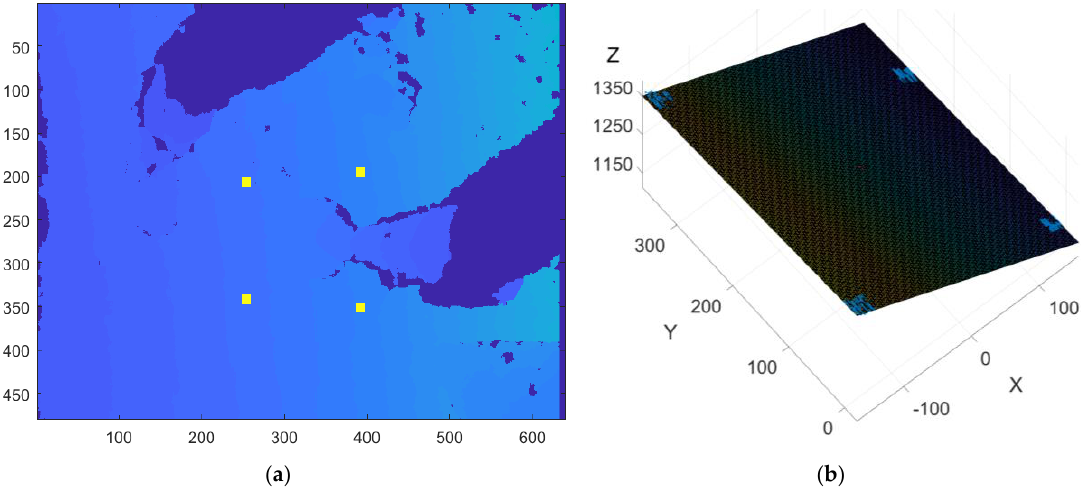
Figure 5. Generation of the ground plane using the RANSAC algorithm: ( a ) Depth image captured by Kinect during a slump test and the selection of four rectangular areas; ( b ) Ground plane generated from the RANSAC algorithm using the selected data.